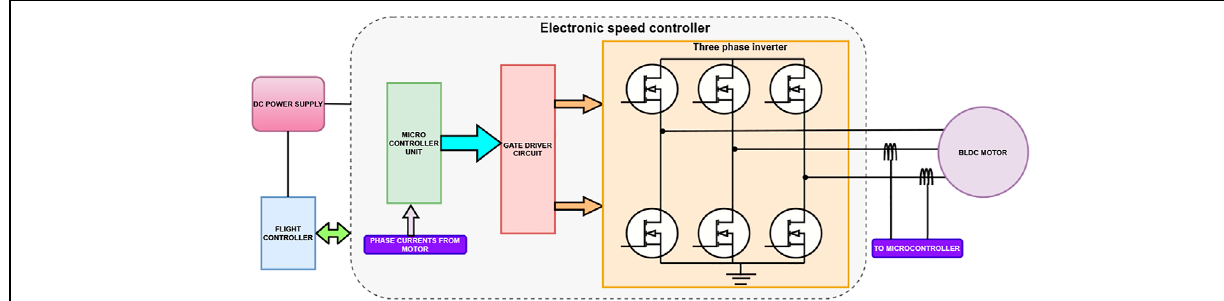
FIGURE 4 | Diagram of electronic speed controller Designs (2016)